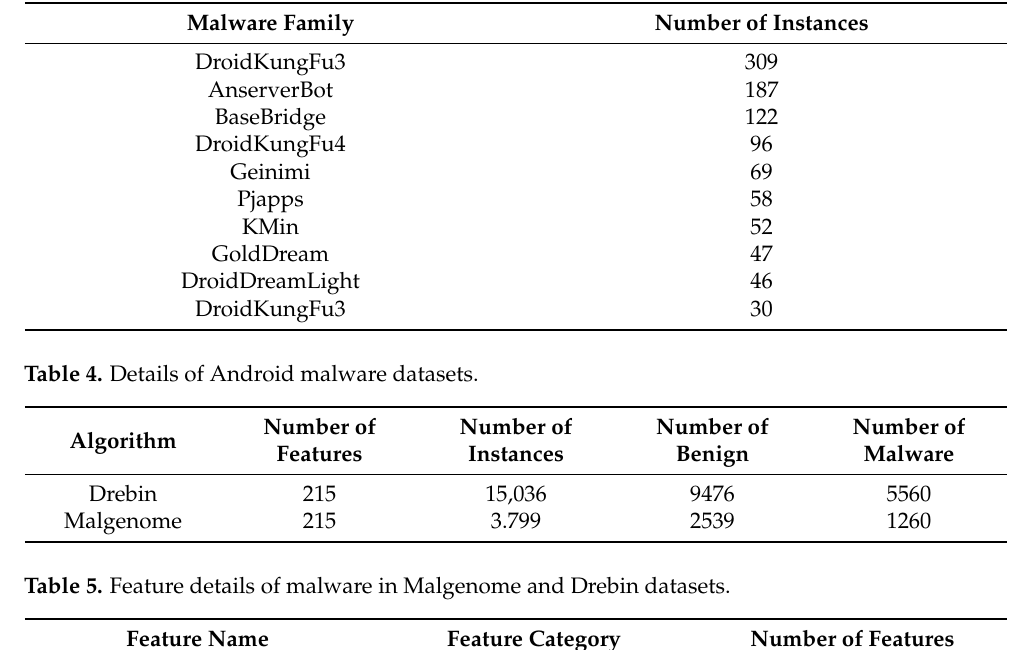
Table 3. Top 10 malware families in the Malgenome dataset.